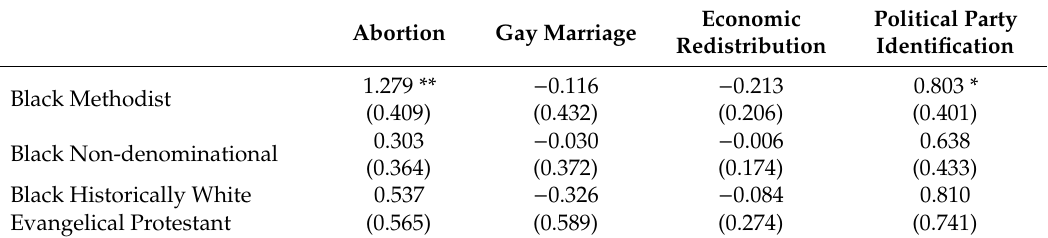
Table A2. Original results from the OLS models of examining the interaction of education and specific religious a ffi liation among Black Protestants (Black Baptist as